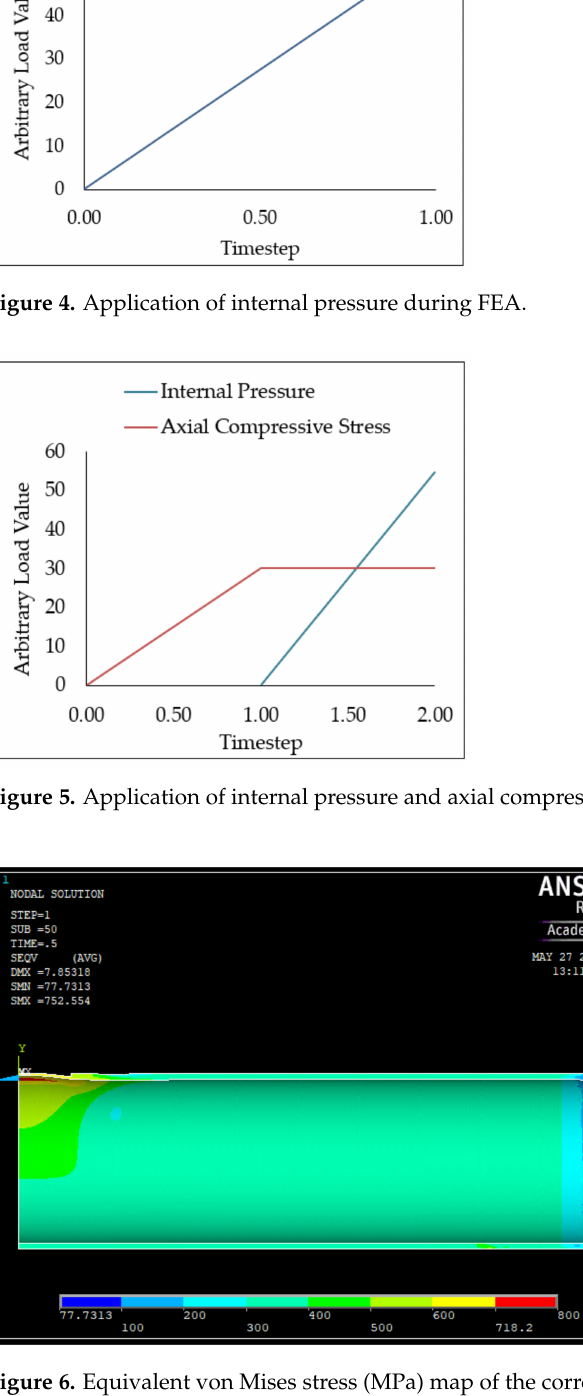
Figure 6. Equivalent von Mises stress (MPa) map of the corroded pipe after